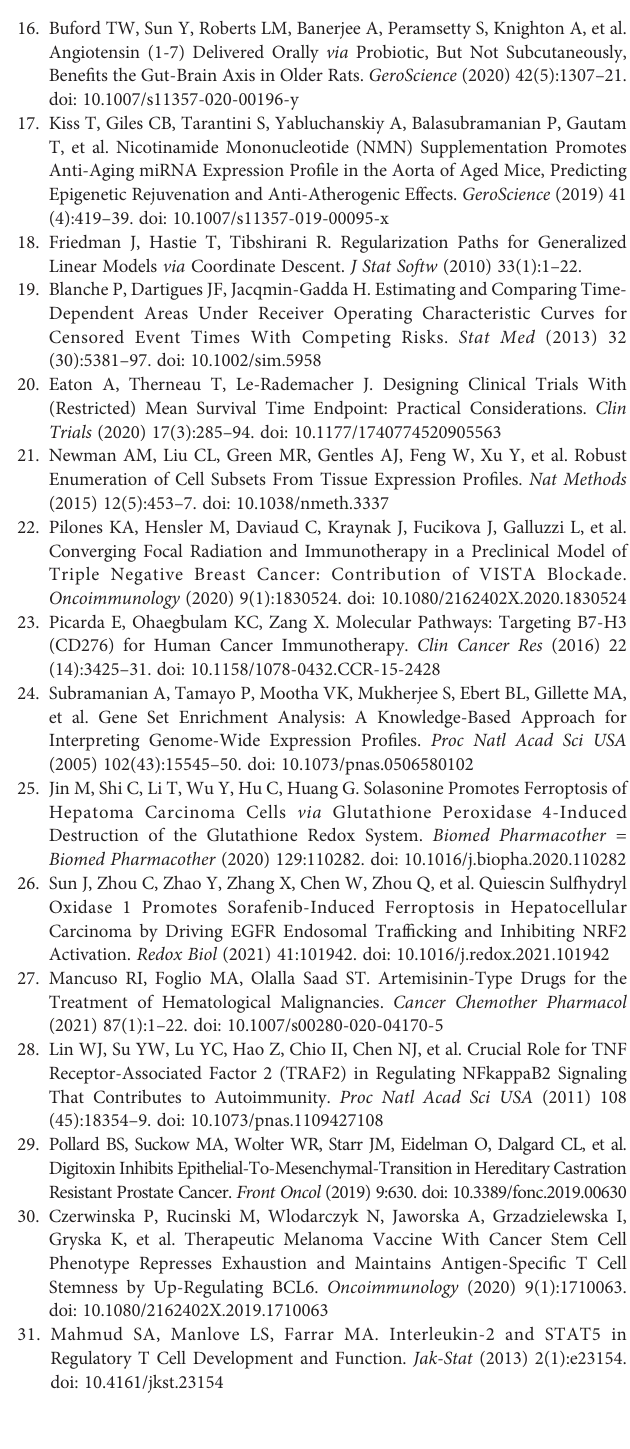
Supplementary Figure 2 | Effects of CTD-2033A16.3, LINC01231, and LINC01508 on the apoptosis and proliferation of hepatocellular carcinoma (HCC) cells HUH-7. (A) qPCR analysis of lncRNA expression after transfection with the lncRNA-targeted siRNAs. (B, C) The inhibition of CTD-2033A16.3, LINC01231, and LINC01508 by siRNAs leads to the promotion of cell apoptosis rate. (D, E) The inhibition of CTD-2033A16.3, LINC01231, and LINC01508 by siRNAs leads to the